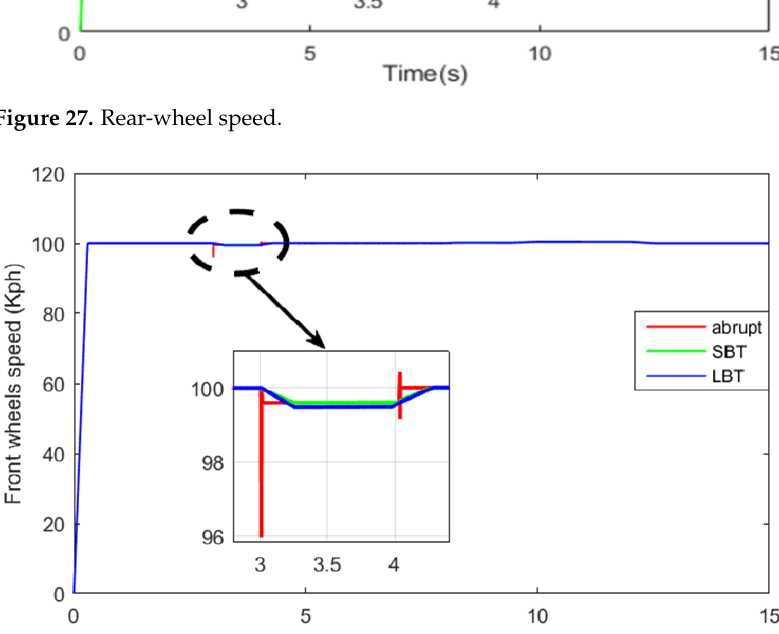
Figure 28. Front-wheel speed.